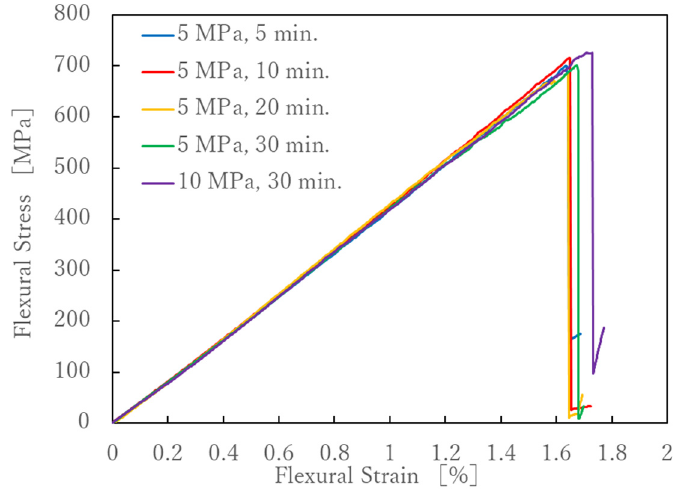
Figure 10. Stress-strain curves of the four-point flexural test.